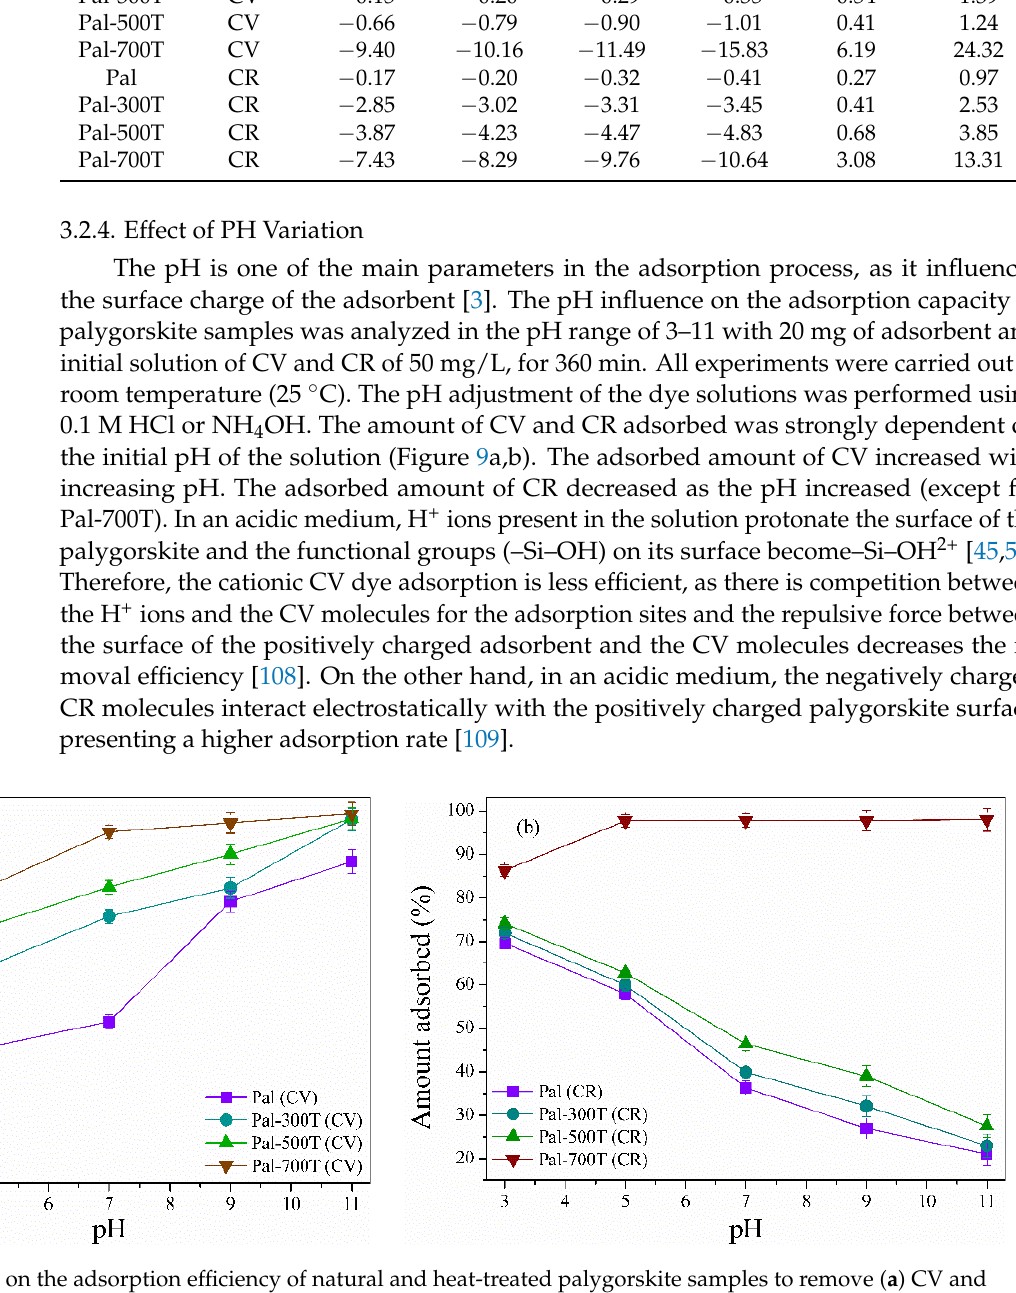
Figure 9. Effect of pH on the adsorption efficiency of natural and heat-treated palygorskite samples to remove ( a ) CV and ( b ) CR.